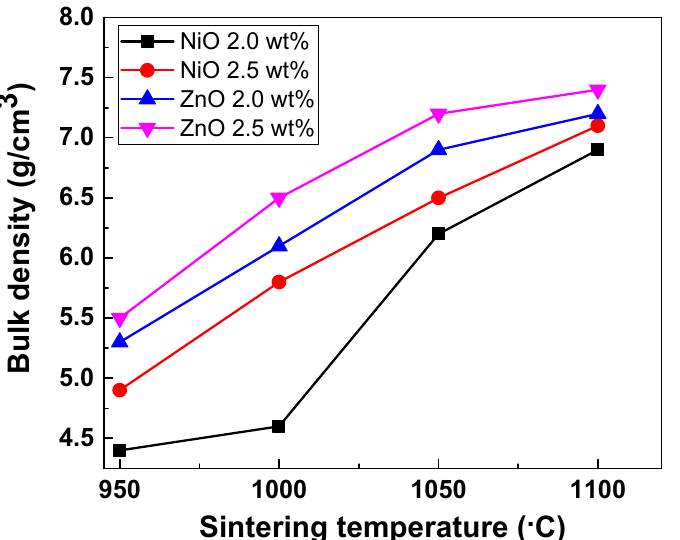
Figure 1. Changes in bulk density of (Pb 0.88 , La 0.12 )(Zr 0.86 , Ti 0.14 )O 3 according to the addition of NiO and ZnO.